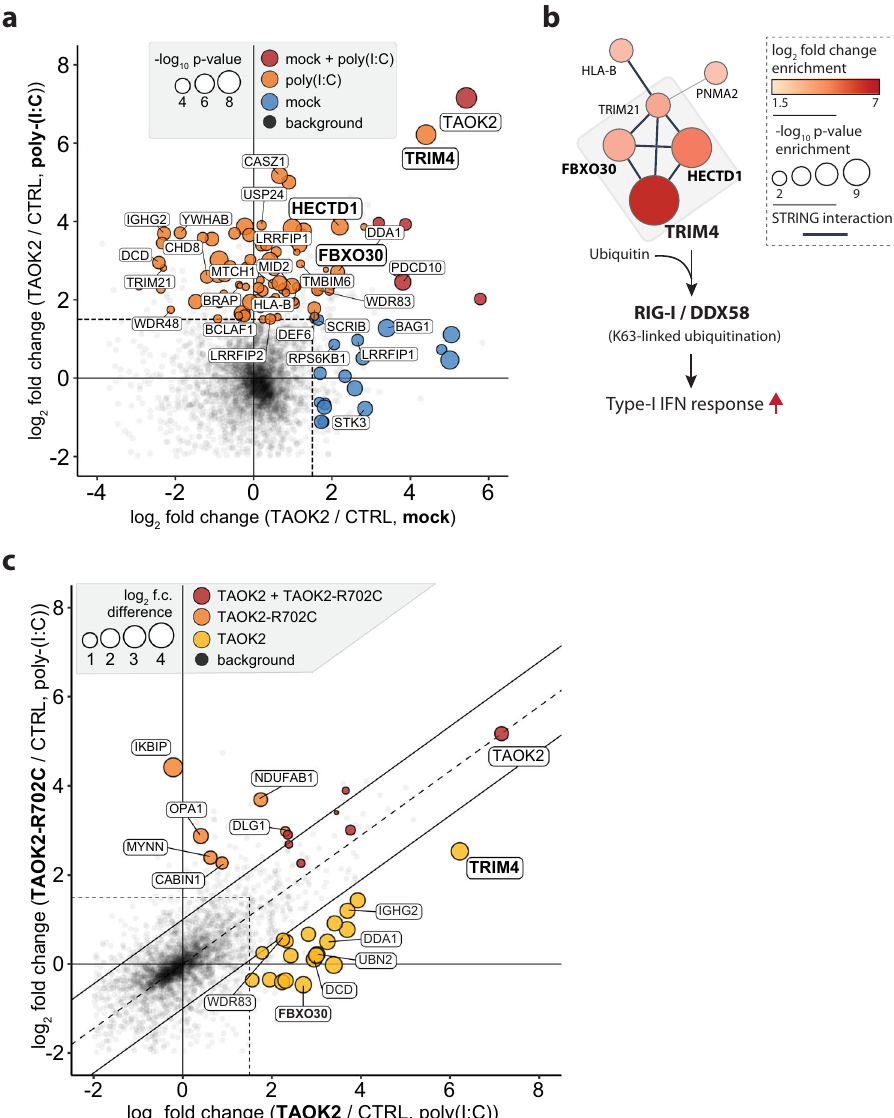
Fig. 8 TAOK2 interacts with TRIM4, a known enhancer of RIG-I-dependent innate immune responses. a Scatter plot showing the log 2 fold change enrichment of proteins following af fi nity puri fi cation of rat TAOK2 as compared to the combined control (CTRL) baits (PGAM5 and EGFP) in mock ( x -axis) and poly(I:C) stimulated ( y -axis) HEK293T cells. Signi fi cantly enriched proteins were identi fi ed by a two-sided Student ’ s t -tests (permutation-based FDR <0.05), further fi ltered to show a log 2 fold change of ≥ 1.5, and colored in blue (only signi fi cant in mock), orange (only signi fi cant upon poly(I:C) stimulation), red (signi fi cant in mock and upon poly(I:C) stimulation), or black (nonsigni fi cant or signi fi cant but a log 2 fold change <1.5). Node size corresponds to the − log 10 p value of a given bait versus control comparison and the node size for red-colored proteins is averaged between the two TAOK2 versus CTRL comparisons for mock and poly(I:C) stimulation. b STRING enrichment of rat TAOK2 interacting proteins in mock and poly(I:C) stimulated cells identi fi ed a functionally connected ubiquitin ligase complex, including TRIM4, an enhancer of type-I IFN responses by mediating RIG-I ubiquitination. c Scatter plot comparing the log 2 fold change enrichment of proteins following af fi nity puri fi cation of wild-type rat TAOK2 ( x -axis) versus rat TAOK2- R702C ( y -axis) in poly(I:C) stimulated HEK293T cells. Signi fi cantly enriched proteins were identi fi ed by a two-sided Student ’ s t -tests (permutation-based FDR <0.05), further fi ltered to show a log 2 fold change of ≥ 1.5, and colored in yellow (only signi fi cant in wild-type TAOK2 with a log 2 fold change difference ≥ 1 between wild-type and R702C-mutated TAOK2 af fi nity puri fi cations), orange (only signi fi cant in TAOK2-R702C with a log 2 fold change difference ≥ 1 between R702C-mutated and wild-type TAOK2 af fi nity puri fi cations), red (signi fi cant in both wild-type and R702C-mutant TAOK2), or black (nonsigni fi cant, signi fi cant but a log 2 fold change <1.5, or signi fi cant and a log 2 fold change ≥ 1.5 but an absolute log 2 fold change difference <1 between